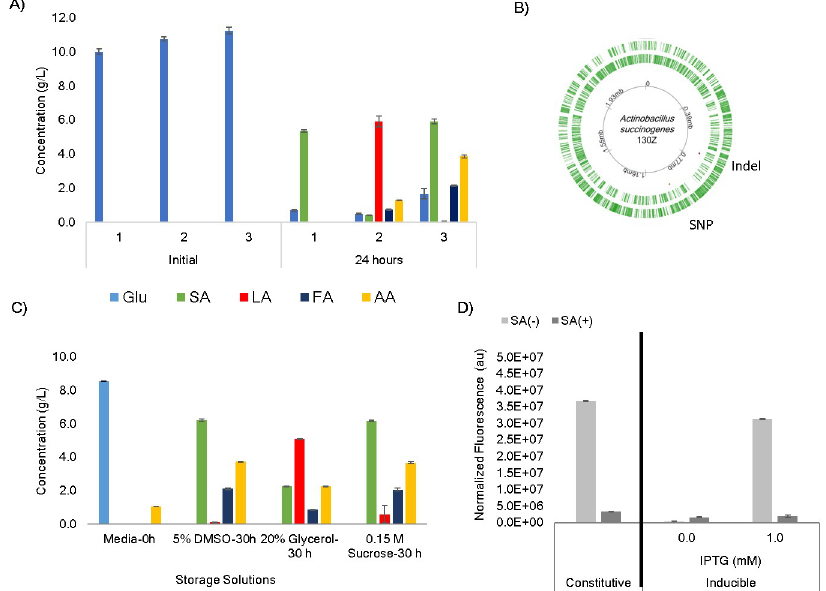
Fig 5. Findings related to succinic acid production loss in A . succinogenes . (A) Comparison of organic acid fermentation profiles between A . succiongenes working stock at the beginning of use in the lab (labeled 1 on the x-axis), ten months later (labeled 2), and a newly purchased strain (labeled 3) after 24 hours growth. Data was not collected for lactic acid, formic acid, or acetic acid in the first fermentation in the lab (labeled 1). (B) A . succinogenes genome map indicating positions of the indel mutation (loss of 5 nts) and SNP mutation (A- > G) shown to be different in the SA(-) strain. (C) Production profiles of wildtype, SA(+) A . succinogenes after 30-hour fermentation following storage in DMSO, sucrose, and glycerol and being subjected to 10 freeze/thaw cycles. (D) GFP expression data in transformed SA (+) and SA(-) strains under the control of BBa_J23100 and p100i. Glucose (Glu), succinic acid (SA), lactic acid (LA), formic acid (FA), acetic acid (AA). All error bars represent standard